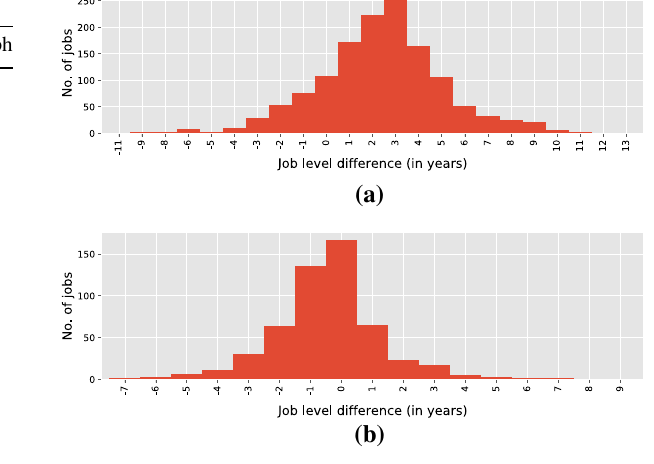
Fig. 8 Discrepancy of job level. a Singapore versus Switzerland. b Singapore versus Hong Kong